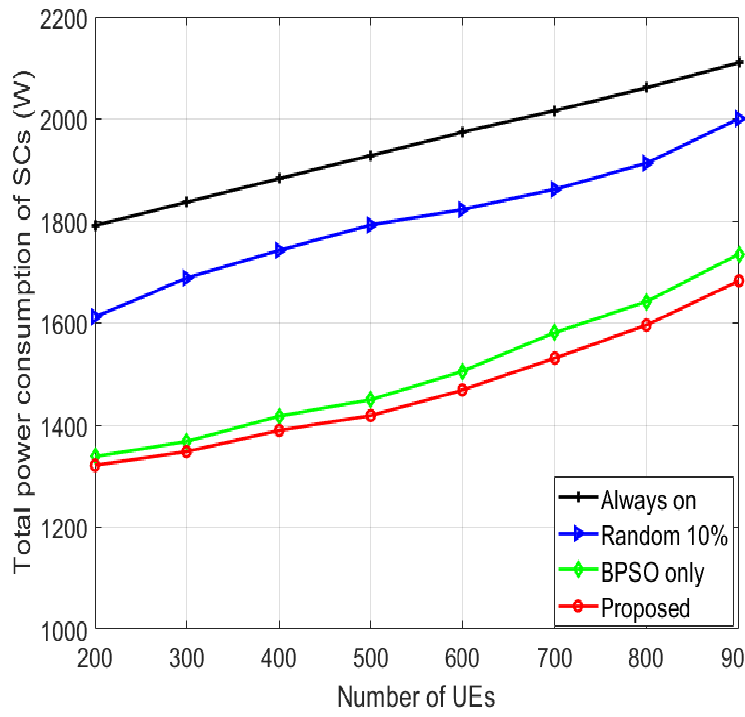
Figure 8. Total system power consumption for various numbers of UEs.